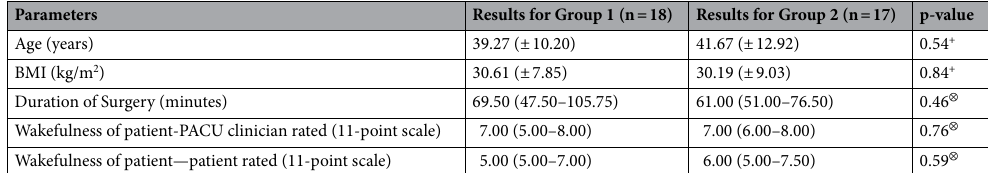
Table 1. Baseline patient characteristics. Mean (± standard deviation), Median (25th percentile to 75th percentile), + Independent samples t-test, ⊗ Mann–Whitney U-test.